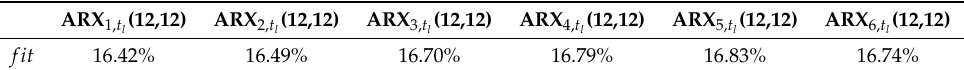
Table 6. Shear frame: GPR modelling results for the noise variance of the associated ARX models.